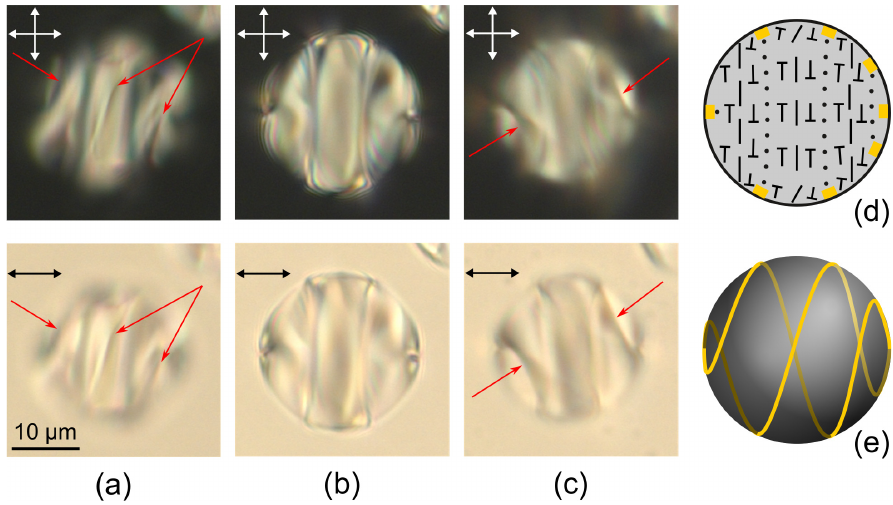
Figure 4. POM photos of cholesteric droplets at N 0 = 5.2 taken in the crossed polarisers (top row) and without analyser (bottom row). The microscope is focused on the linear defect above the droplet centre ( a ), on the droplet centre ( b ) and on the linear defect below the droplet centre ( c ). Schemes of the director orientation in the central section of the droplet ( d ) and the twisted defect loop on the droplet surface ( e ). Single arrows indicate a position of the linear